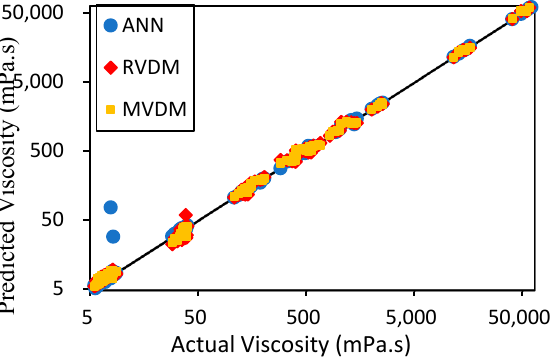
Figure 8. Comparison of the ANN- and empirical-model-predicted values to the experimentally obtained results.